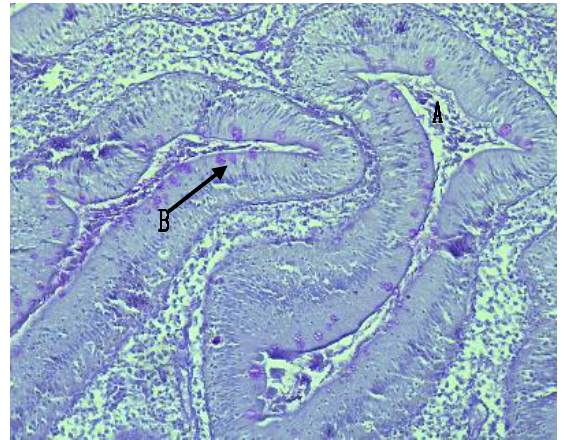
Figure, 5: Cross microscopic section of anterior portion of intestine of common carp, (A)mucosal fold, (B)goblet cell (arrow), PAS stain (X100).